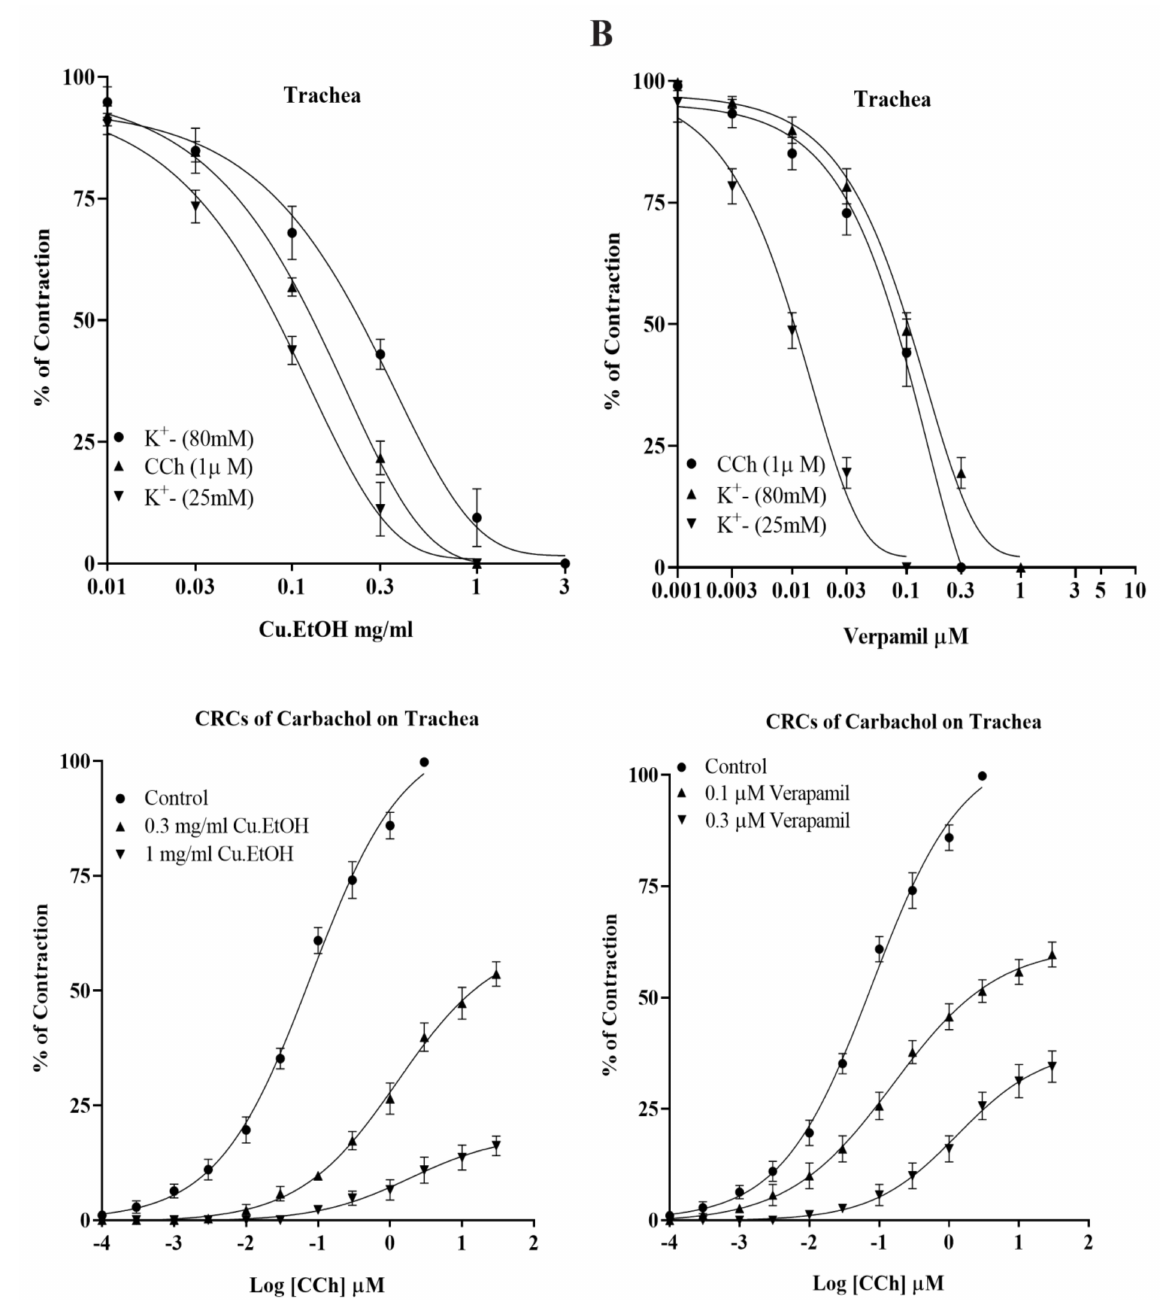
Figure 9. Effect of C. sativus seeds extracts (Cu.EtOH) and verapamil on tracheal preparations in respect of spontaneous, K + (80 mM), carbachol, and K + (25 mM) contraction concentration-response curves. ( A ) Physiological responses of Cu.EtOH ( B ) sigmoidal dose-response curve of Cu.EtOH on tracheal bladder preparations (Values are expressed as Mean ± SD, data was analyzed by sigmoidal dose-response